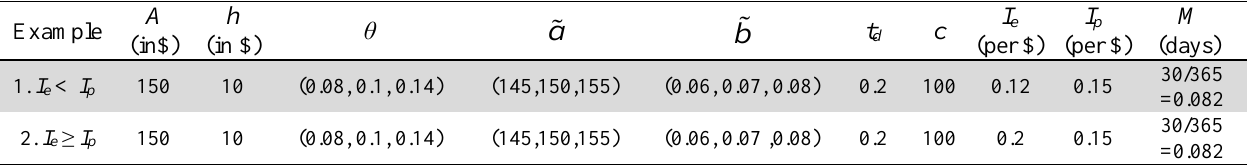
Values of parameters of different examples Example